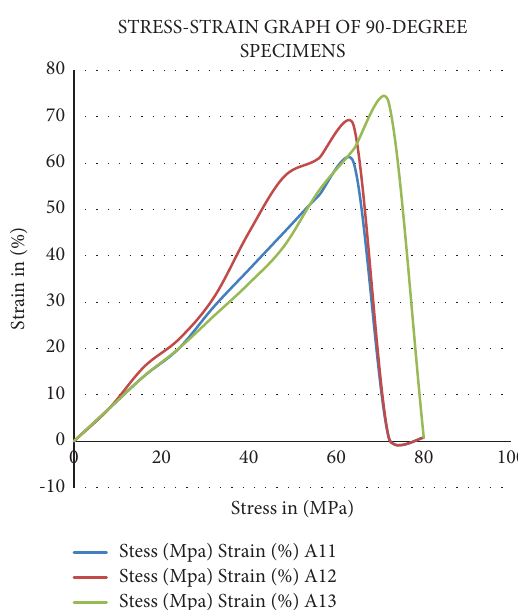
Figure 8: Stress-strain graph of 90 ° fber